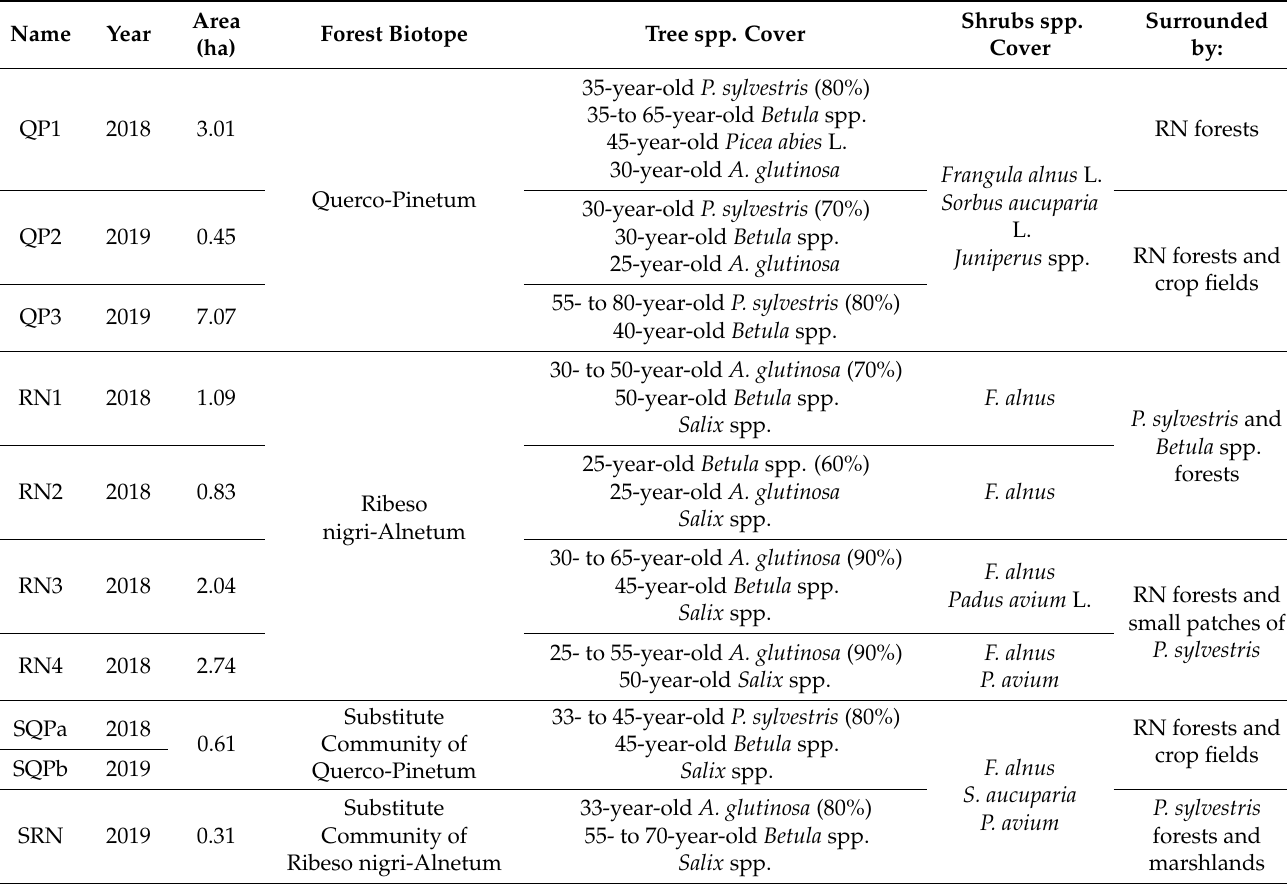
Table 2. Specification of the sites where the inventory of the Macroheterocera fauna was carried